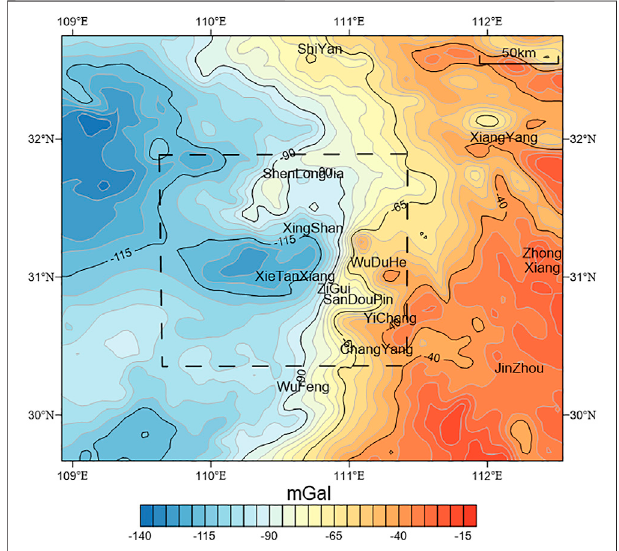
FIGURE 3 | Bouguer gravity anomalies in the Badong – Zigui area. The dashed line represents the inversion area.